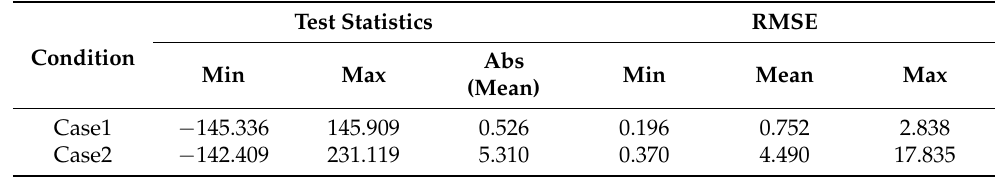
Table 6. Statistics of IICODM threshold (m).